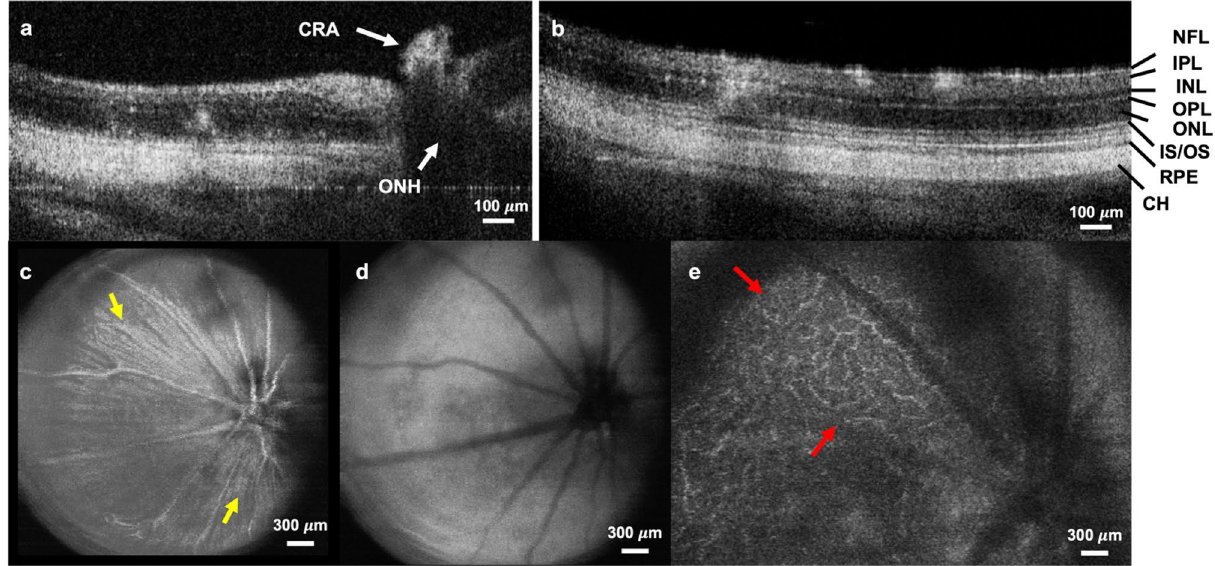
Figure 4. Volumetric and cross-sectional OCT images. Cross-sectional images acquired in-vivo from rat retina showing distinct layers of the retina. CH: choroid, CRA: central retinal artery, INL: inner nuclear layer, IPL: inner plexiform layer, IS/OS junction of inner segment and outer segment layer, NFL: nerve fiber layer, ONL: Outer nuclear layer, ONH: optic nerve head, OPL: outer plexiform layer, RPE retinal pigment epithelium layer. ( a , b ). OCT fundus images visualizing optic nerve head, large retinal vessels, optic nerve fiber bundle (yellow arrows), deeper retinal layer microvasculature (red arrows) ( c – e hemoglobin (higher absorption for oxygenated hemoglobin), arteries appear dark (red arrows), and veins are light (blue arrows) in the image. Therefore, the scattering contrast of the PARS microscope can be used similarly to retinal oximeters to measure oxygen saturation in the eye 40 .